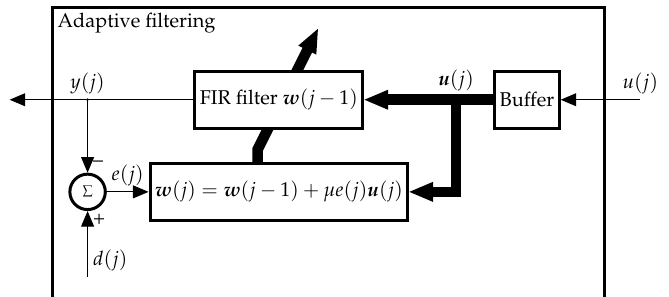
Figure 4. Block diagram of the LMS adaptive